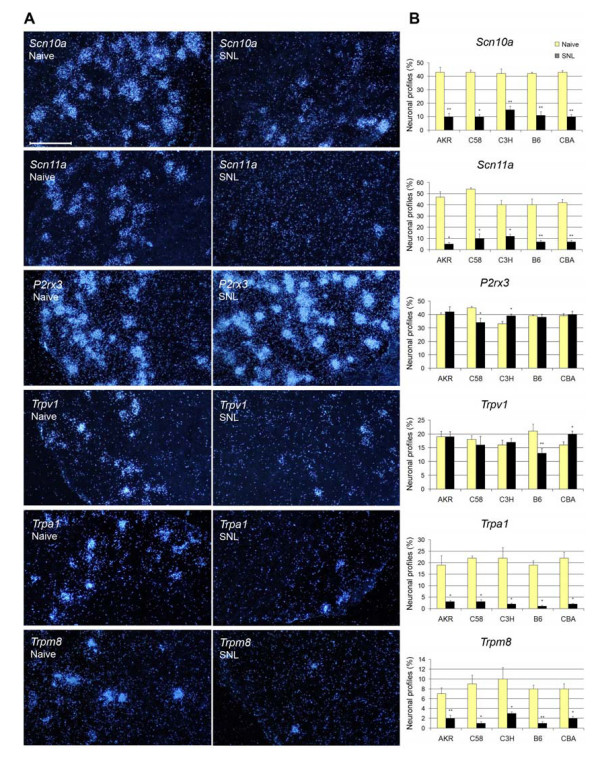
L5 spinal nerve ligation (SNL) alters the expression of mRNAs in the ipsilateral L5DRG. A, Dark-field micrographs display hybridization signals for each of the six transcripts studied: Scn10a, Scn11a, P2rx3, Trpv1, Trpa1 and Trpm8. DRG sections originate from naïve B6 mice (left column) and B6 mice 3 days after SNL surgery (right column). The scale bar refers to all images: 100 μm. B, Column heights (mean ± SEM, n = 4–6) indicate the proportion of DRG neuronal profiles that were positive for expression of each of the six mRNA types in each of the five strains examined. White columns refer to naïve mice; black columns refer to SNL operated mice. Statistical differences between naive and nerve injured mice are indicated with asterisks (Mann-Whitney U test) * p < 0.05; ** p < 0.01.